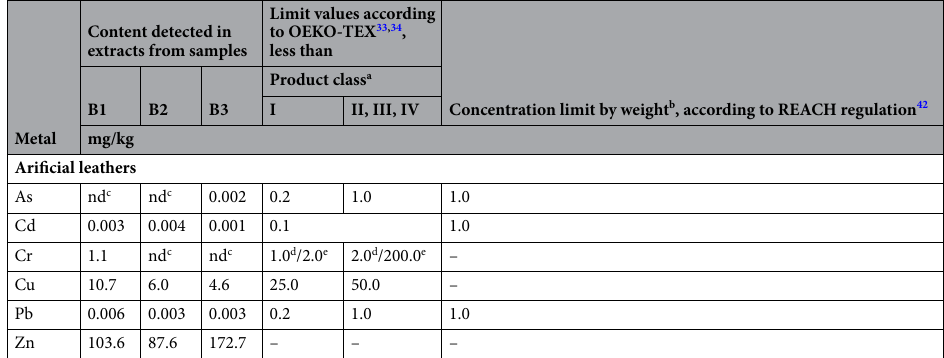
Table 3. As, Cd, Cr, Cu, Pb and Zn content in the extracts obtained from artificial leathers and limits for their content according to OEKO-TEX and REACH regulation. Source: Author’s own research, limits of metal content based on the OEKO-TEX 33,34 —Annexes IV and REACH regulation 42 —Appendix 12. a I—products for infants and young children up to 36 months of age, II—products in direct contact with the skin, III—products in no direct contact with the skin, IV—decorative products; b after extraction, expressed as As, Cd and Pb metal respectively, that can be extracted from the material; c not detected; d limit according to OEKO-TEX 33 ; e limit according to OEKO-TEX 34